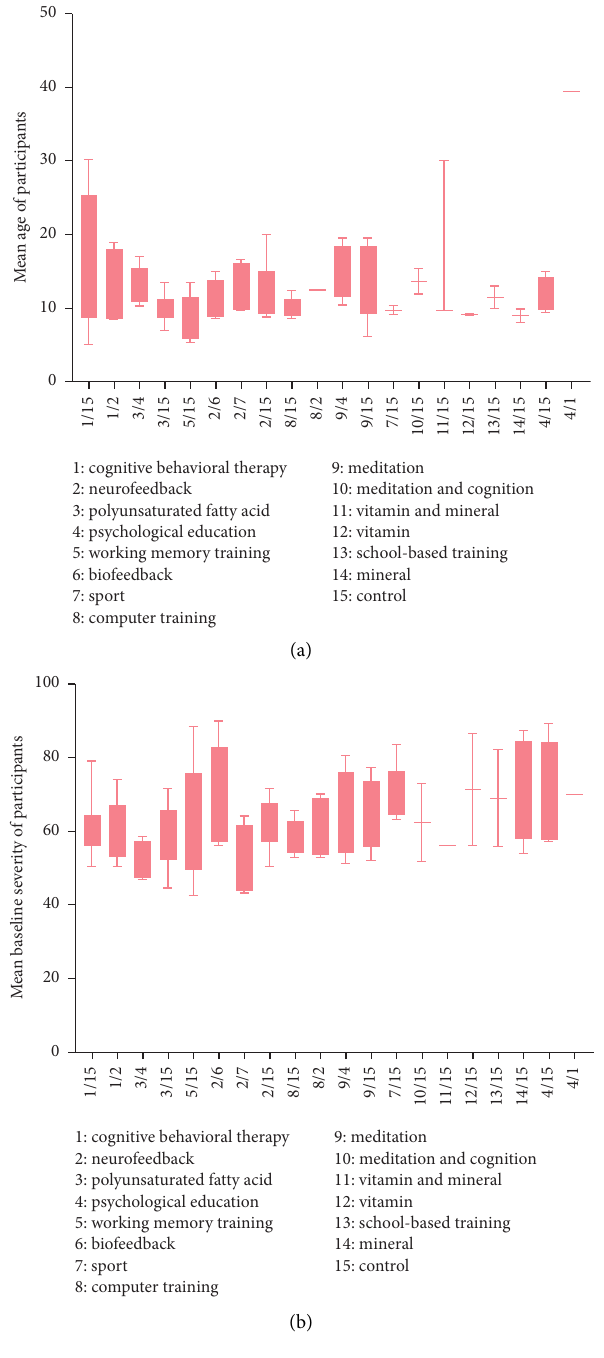
Figure 4: Assessment of